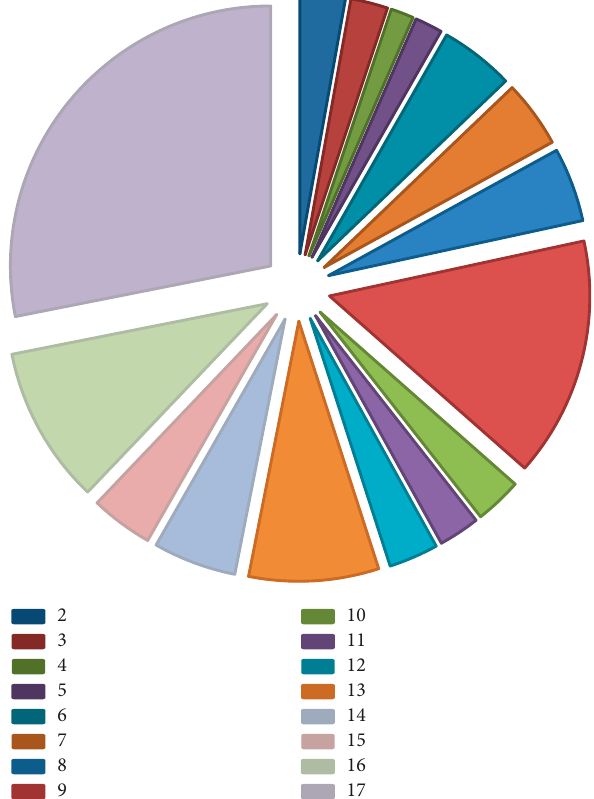
Figure 13: Tolerance index of mung bean plant grown under the stress of Cu 2+ metal and biosorbed water after 15 days of seed germination. T1, negative control; T2, 50mg kg − 1 ; T3, pomegranate peel biosorbed water +50mg kg − 1 ; T4, peanut peel biosorbed water +50mg kg − 1 ; T5, orange peel biosorbed water +50mg kg − 1 ; T6, 100mg kg − 1 ; T7, pomegranate peel biosorbed water +100 mg kg − 1 ; T8, peanut peel biosorbed